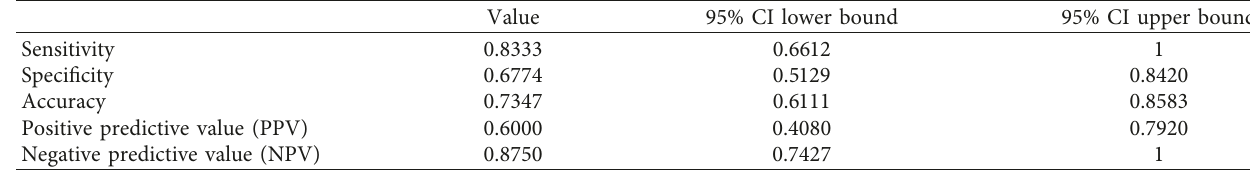
Table 1: Expert observer grouped interpretation of MRI compared to final pathologic diagnosis.